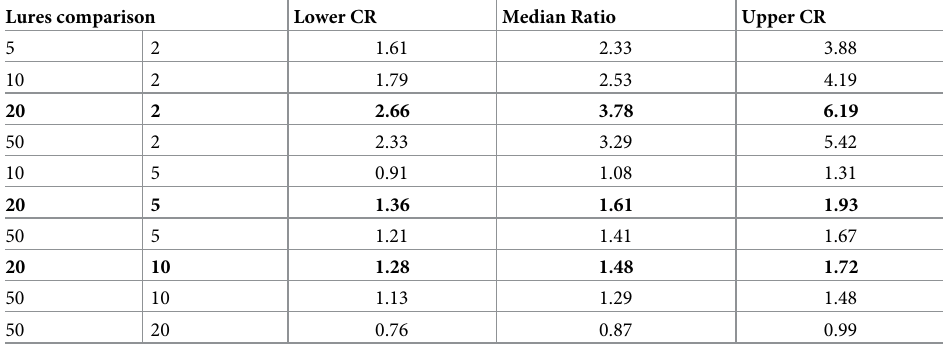
Table 7. Ratio of the β coefficients for the levels of pheromones and 95% credible intervals. Lures